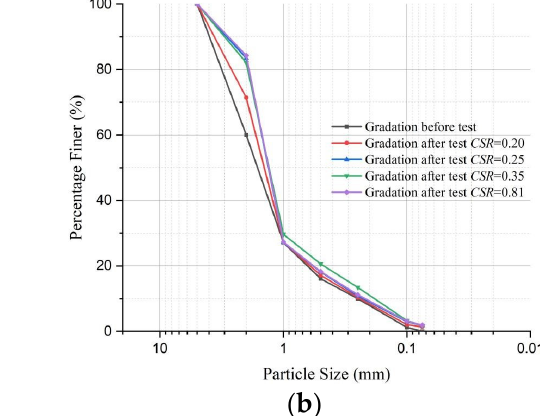
Figure 17. Particle gradation of different CSR samples before and after the test: ( a ) 60 kPa; ( b ) 100 kPa.